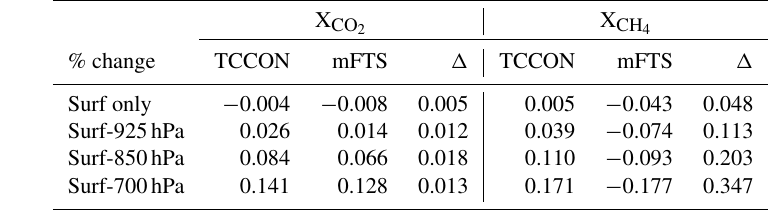
Table 2. Percent changes for T sensitivities at an air mass of 1.5 and a temperature change of + 10K.